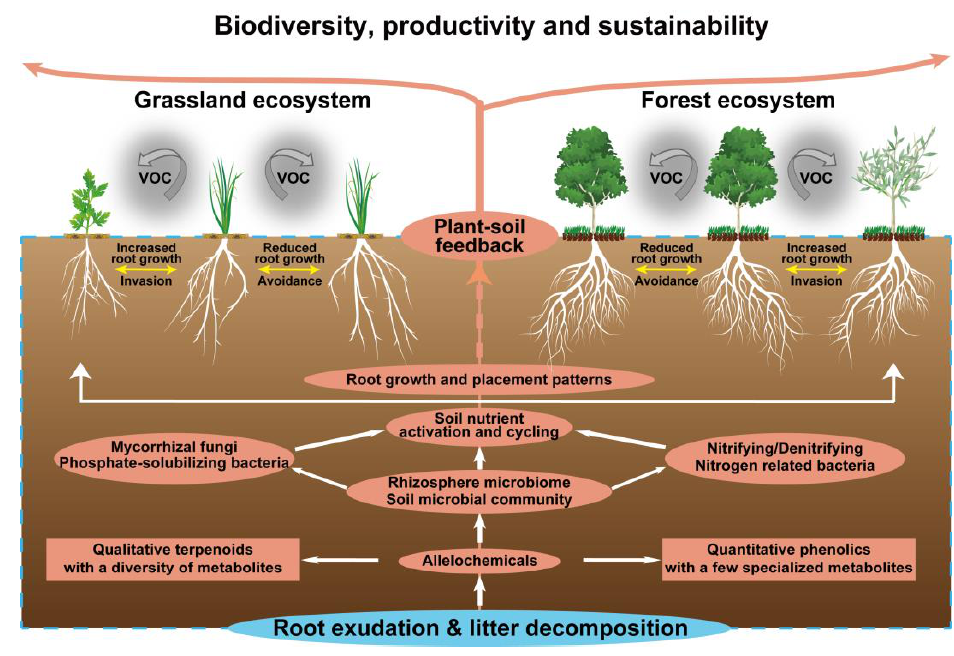
Figure 4. Allelochemical-mediated below-ground interactions and plant – soil feedback.